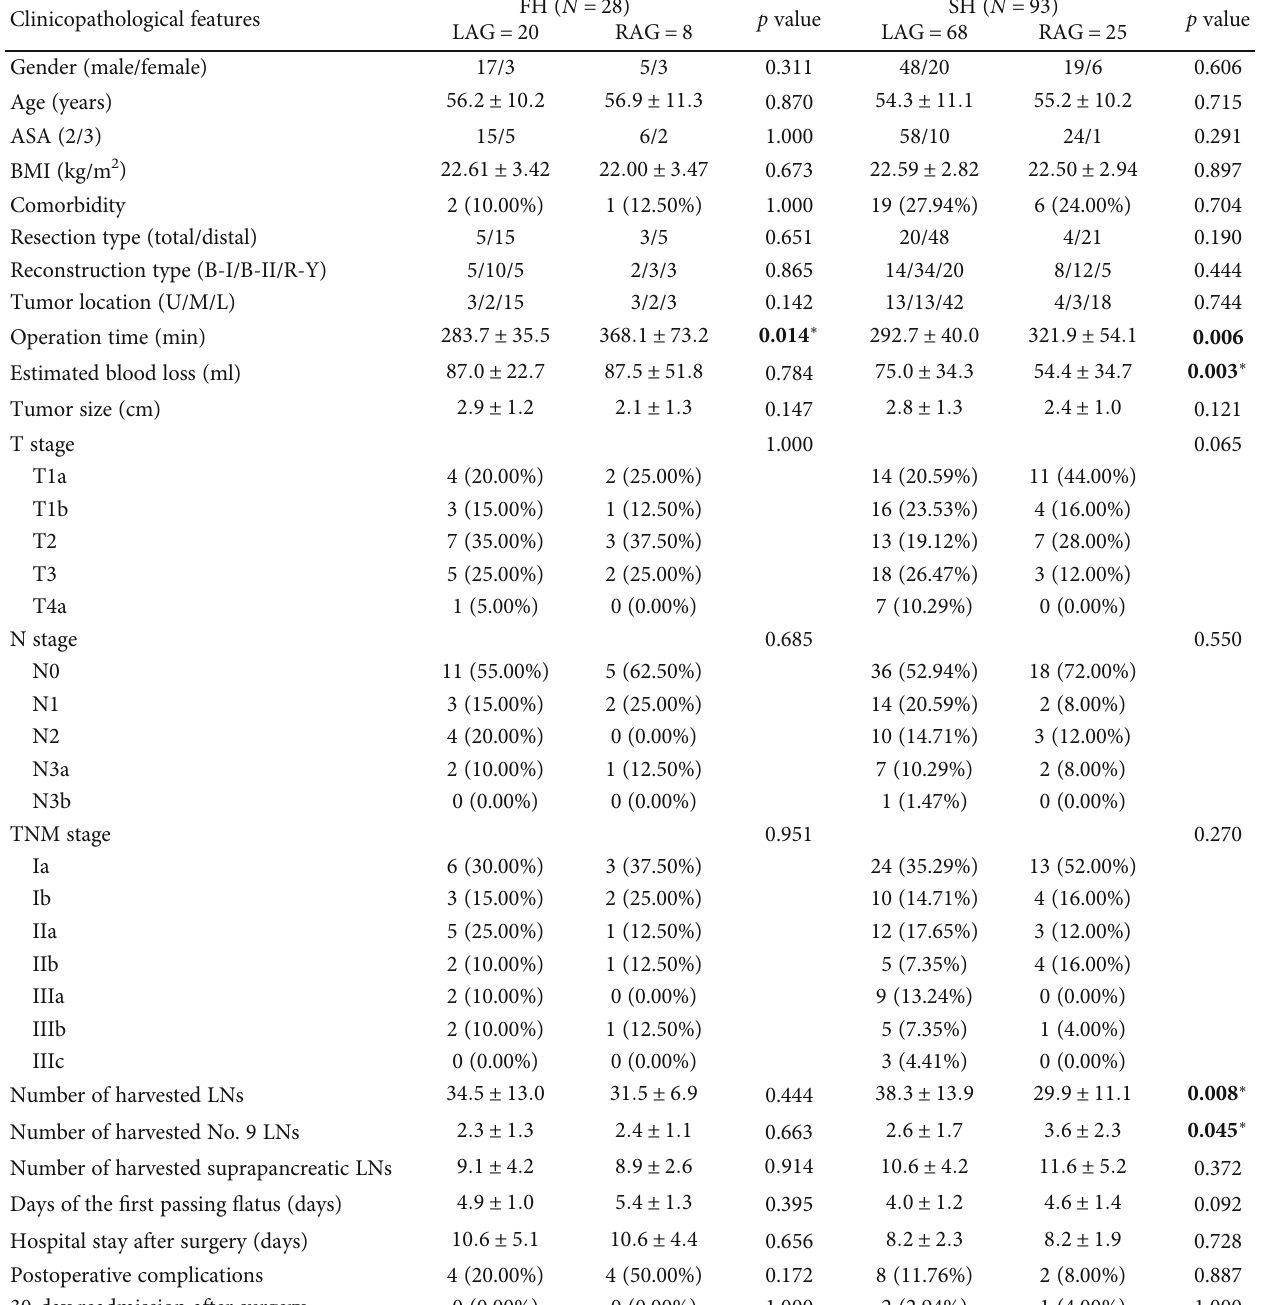
Table 2: Comparison of two subgroups according to the learning curve of the RAG group. Clinicopathological